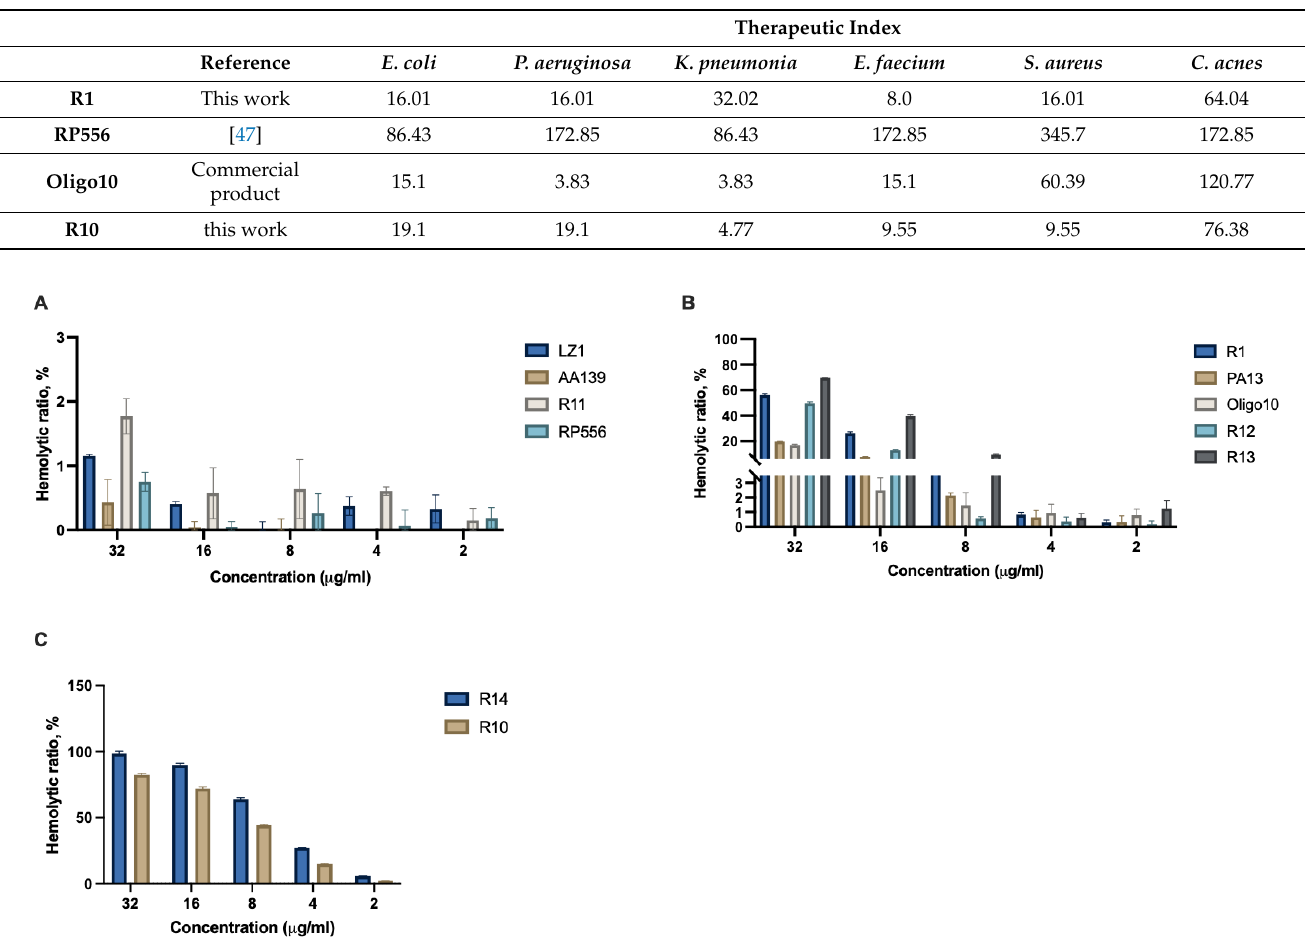
Figure 3. Hemolysis of fresh human blood by antimicrobial peptides AA139, LZ1, R11, R2 ( A ), R1, PA13, Oligo10, R12, R13 ( B ) and R14m R10 ( C ). n =